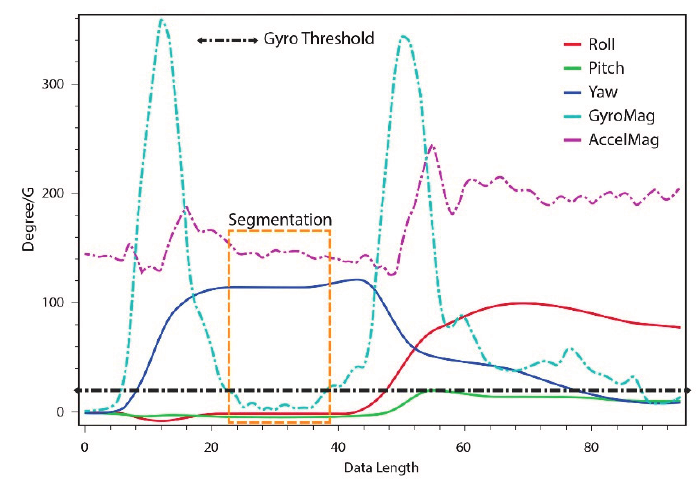
Figure 5. Acceleration and gyro-based gesture